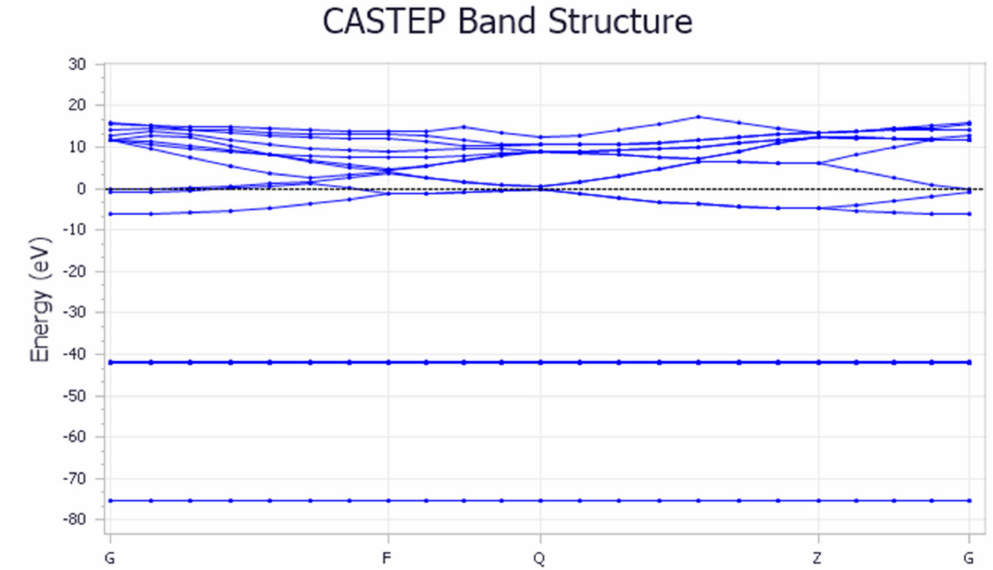
Figure 4. Band structure of the Mg slab using first-principle calculation.